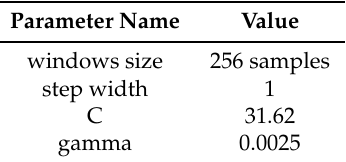
Table 2. Parameters for applied sliding windows and for the trained SVM.